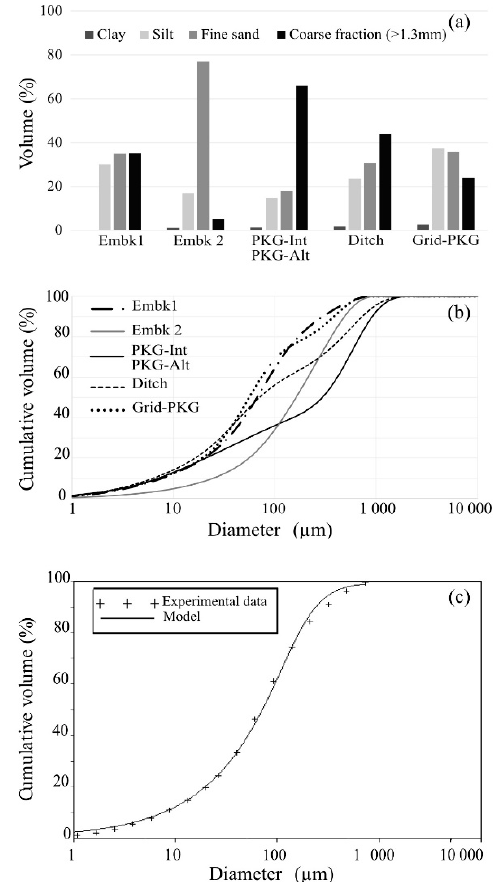
Figure 2. ( a ) Granulometry fractions of the studied soils, ( b ) particle size distributions of the fine fractions (<1.3 mm) and ( c ) example of particle size distribution fitting by the BEST method (Embk 1). Table 3. Hydraulic shape parameters ( n , m, and η ) and shape parameter function c p